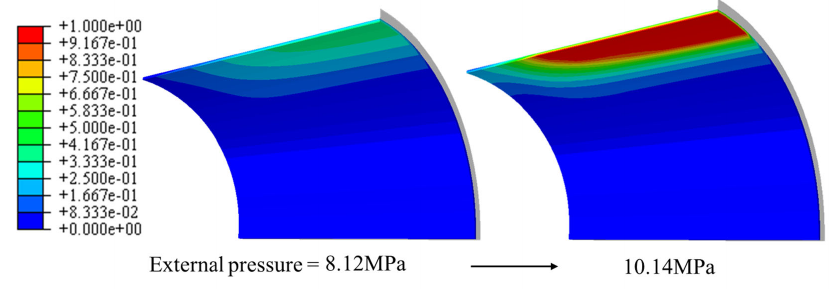
Figure 14. Quadratic displacement damage initiation criterion for cohesive surfaces.